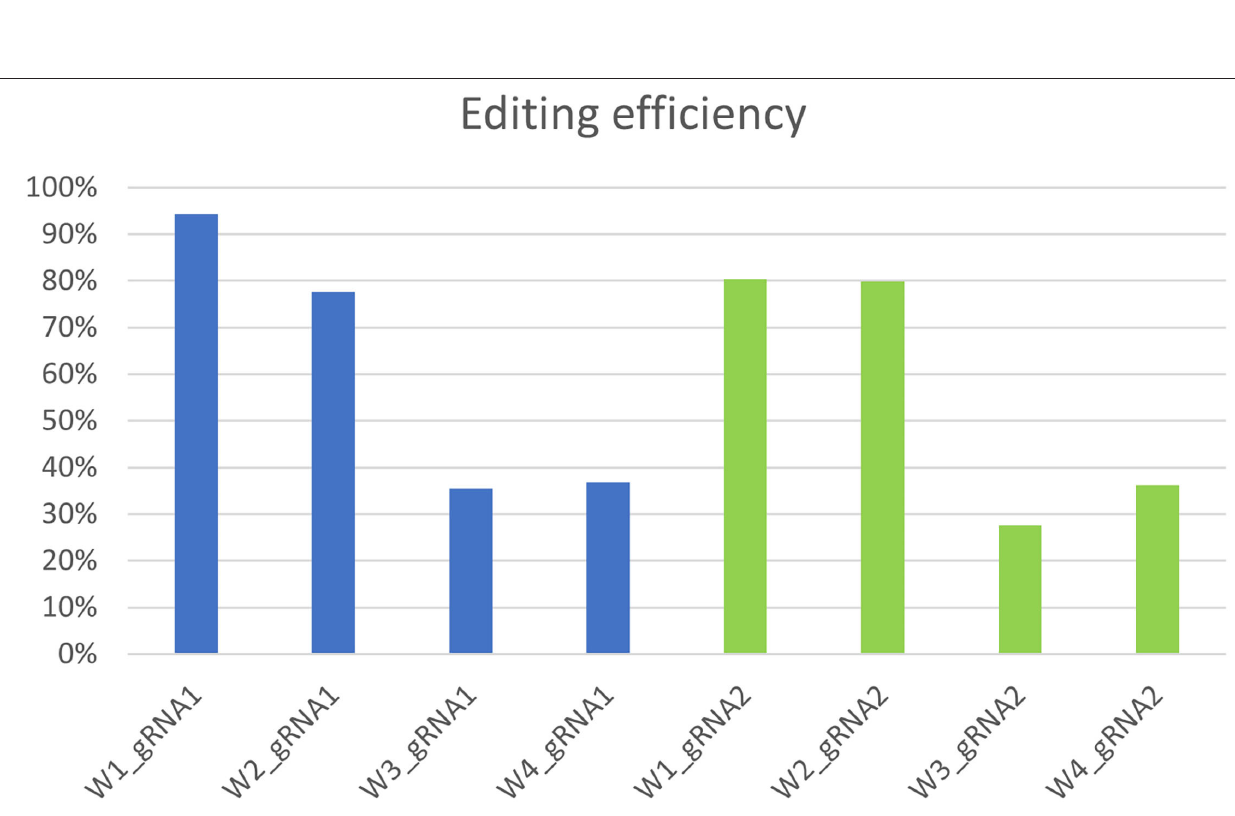
Frontiers in Plant Science |